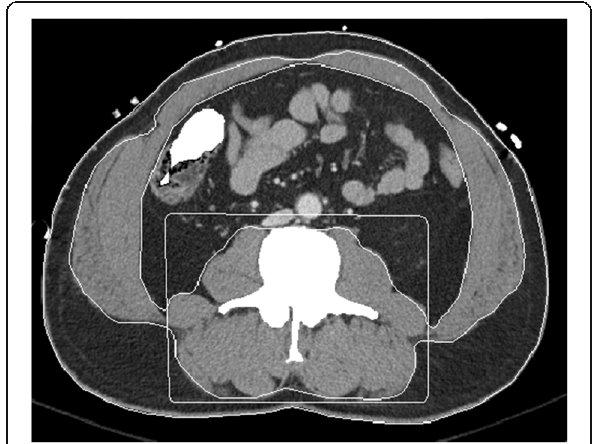
Fig. 3 Segmentation of a computed tomography image of a 55- year-old nonsarcopenic male with a skeletal muscle index of 72 cm 2 /m